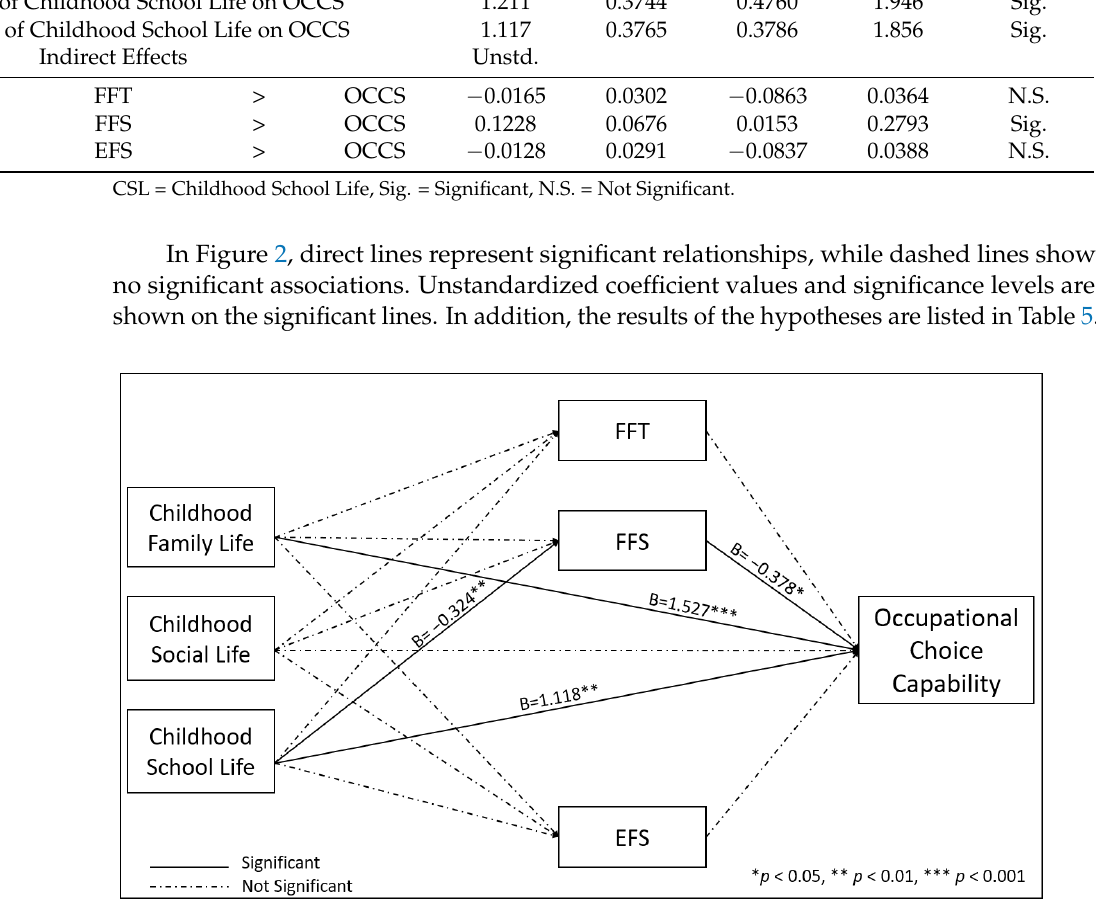
Figure 2. Results of the Proposed Conceptual Model. Table 5. Summary of Hypotheses Testing Results.